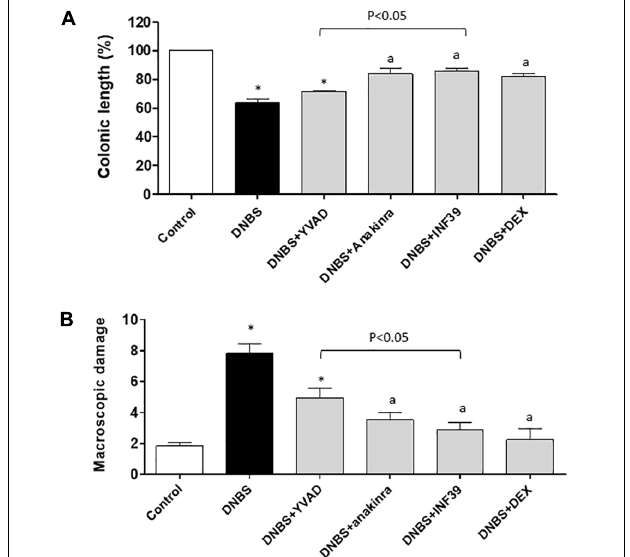
FIGURE 2 | Colonic length changes (A) and macroscopic damage score (B) in rats under normal conditions or with DNBS-induced colitis, either alone or after treatment with Ac-YVAD-cmk (YVAD, 3 mg/Kg), anakinra (100 mg/Kg), INF39 (25 mg/kg) or DEX (1 mg/kg). Each column represents the mean ± S.E.M. ( n = 10). ∗ P < 0.05, significant difference vs. control group; a P < 0.05, significant difference vs. DNBS